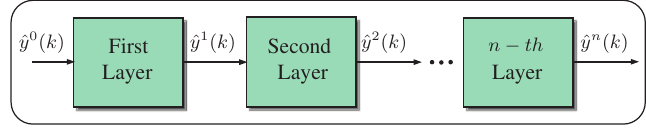
Figure 2. Block diagram of a basic MFNN